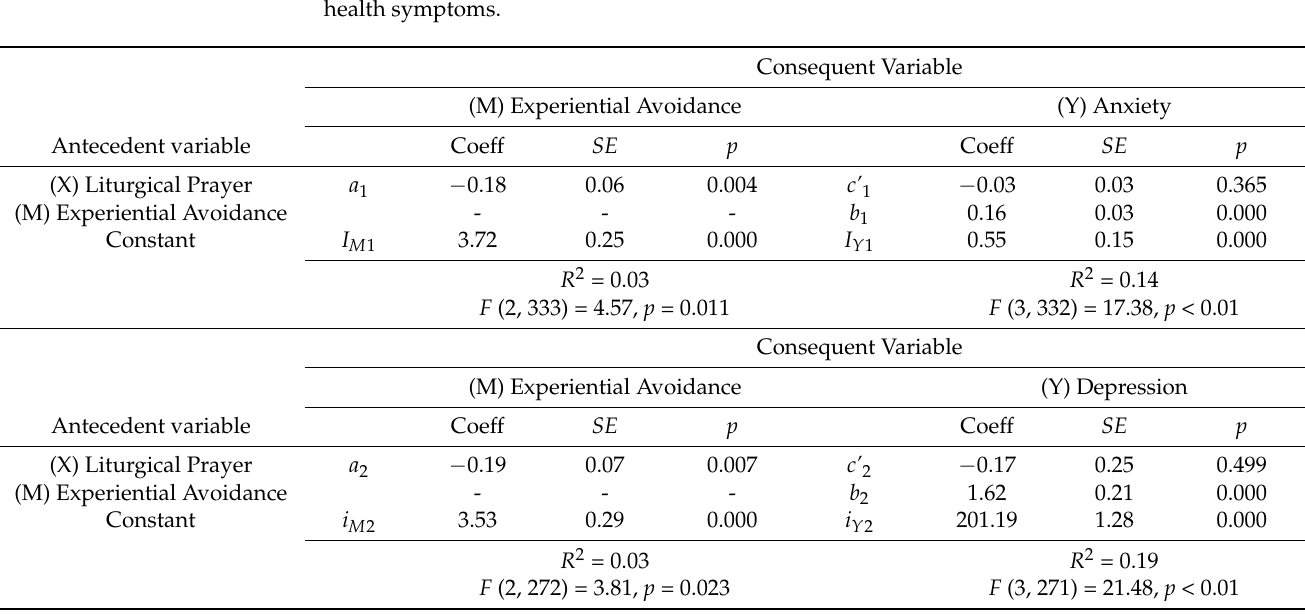
Table 5. Regression models involving liturgical prayer, experiential avoidance, and mental health